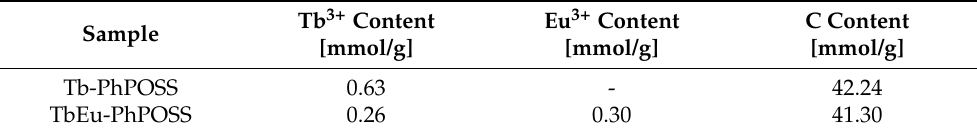
Table 1. Amount of Tb 3+ , Eu 3+ and C elements (in mmol/g) in Tb-PhPOSS and TbEu-PhPOSS.